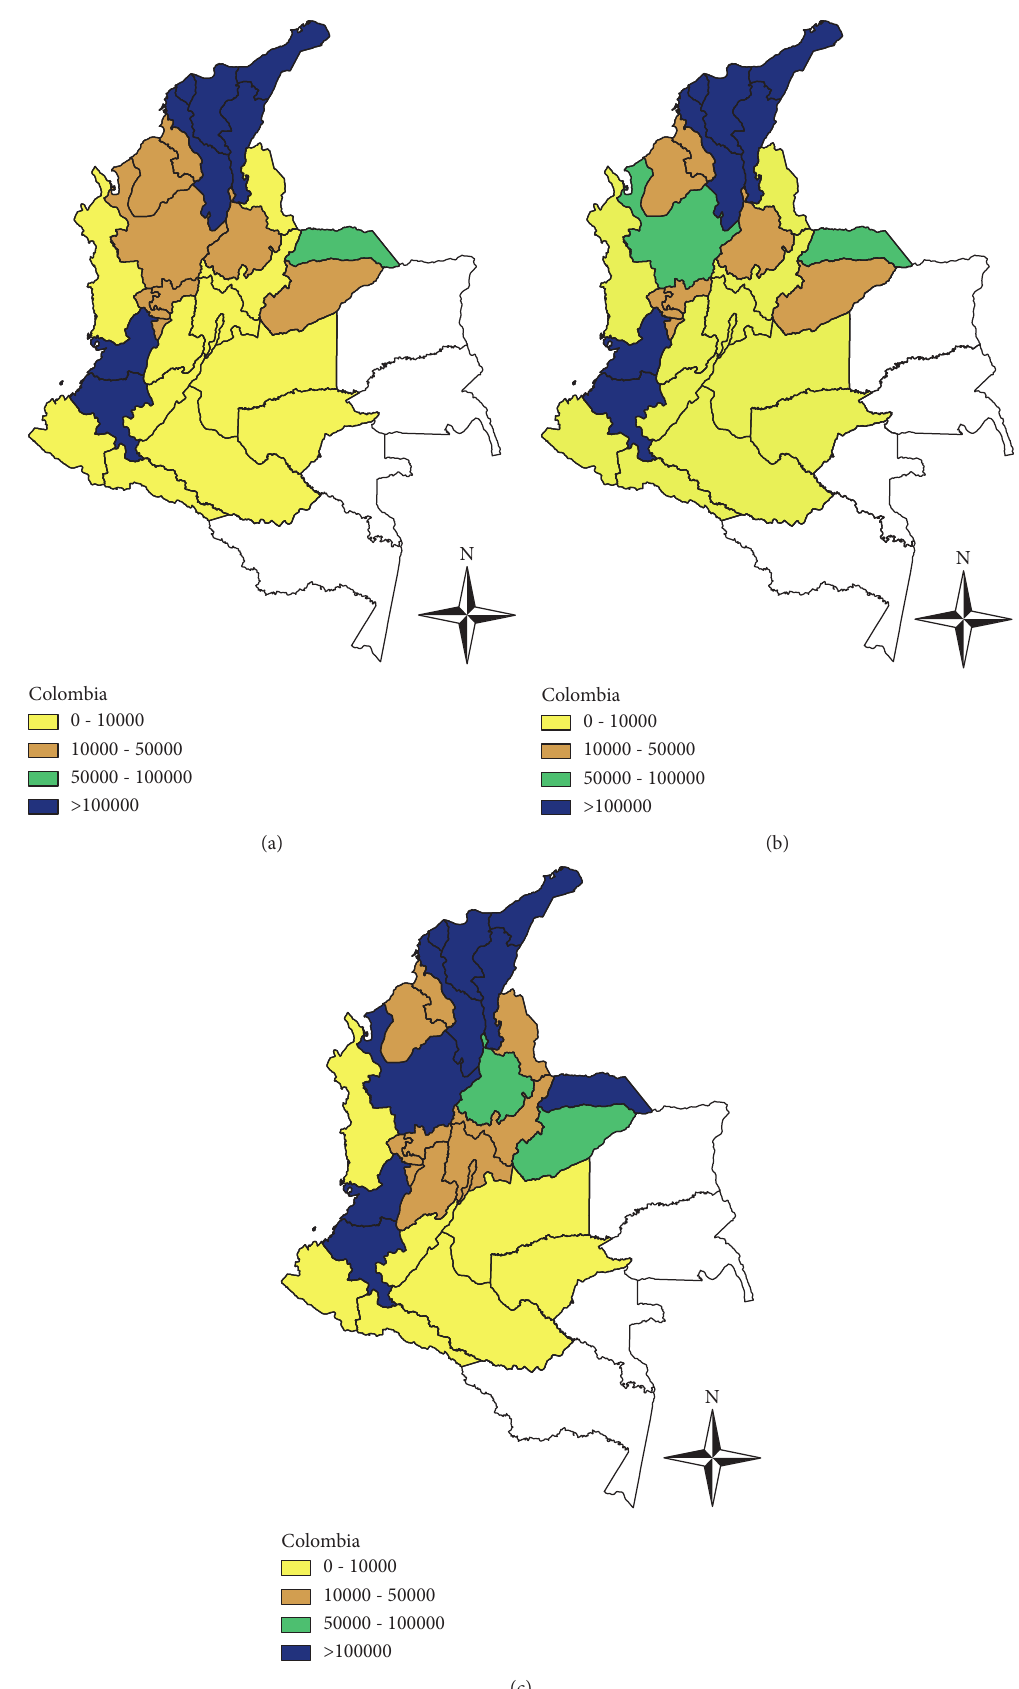
Figure 7: Gravity-based accessibility measure. (a) Gravity-based measure under Scenario 1. (b) Gravity-based measure under Scenario 2. (c) Gravity-based measure under Scenario